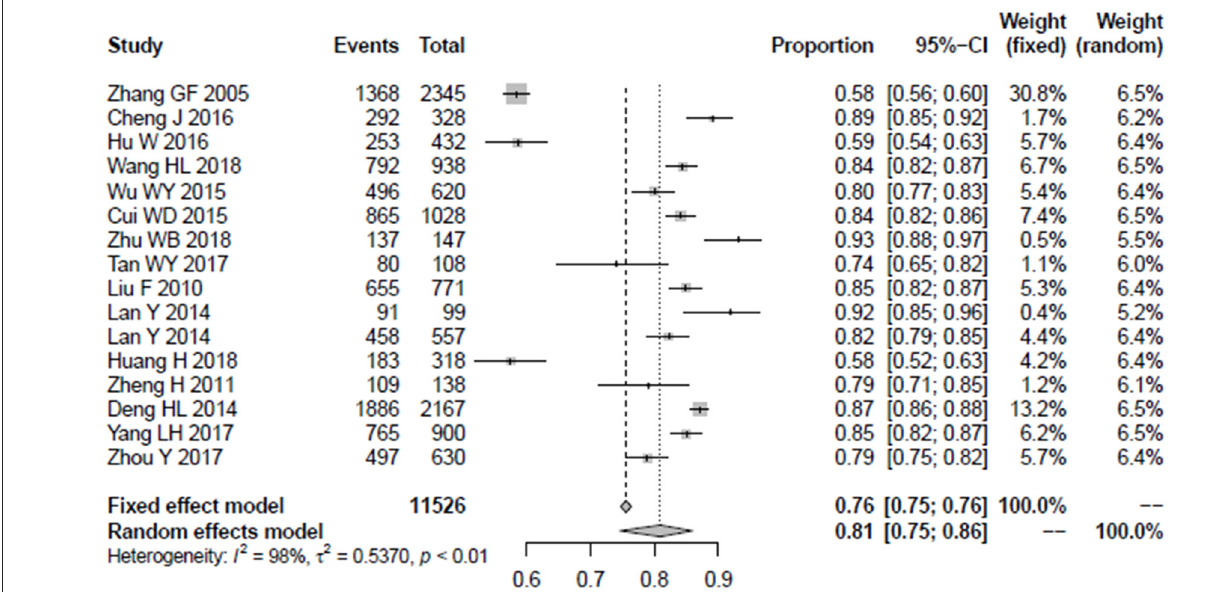
FIGURE 2 | The forest plot of overall awareness rate among medical staff.